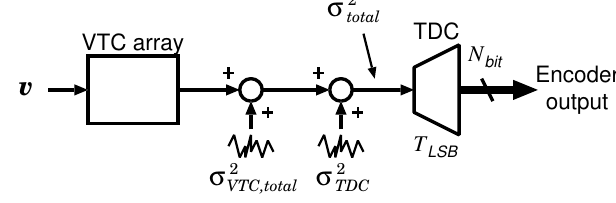
Figure 7. Jitter model of the proposed CS